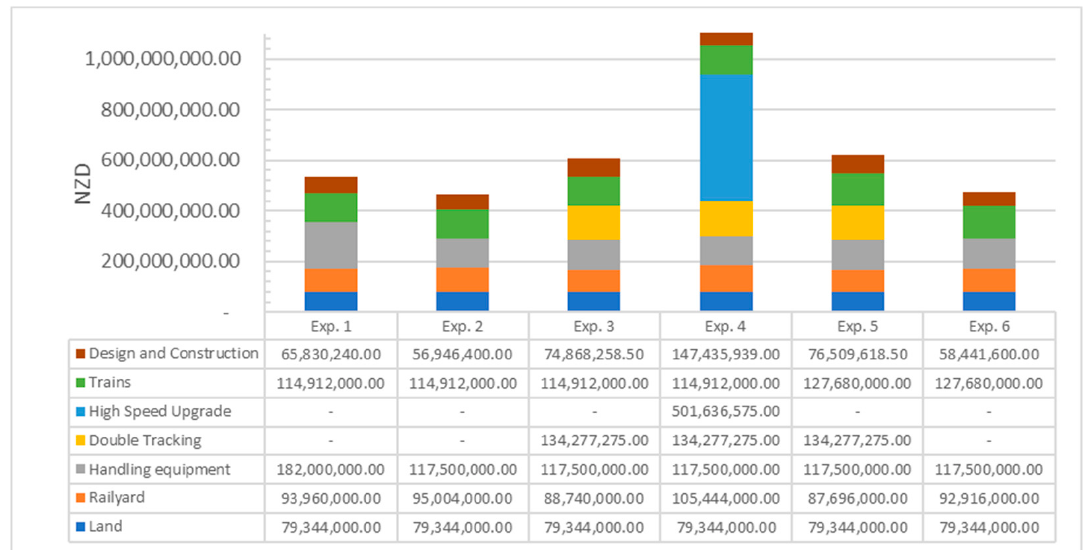
Figure 13. Cost assessment for interventions associated with different simulation experiments.